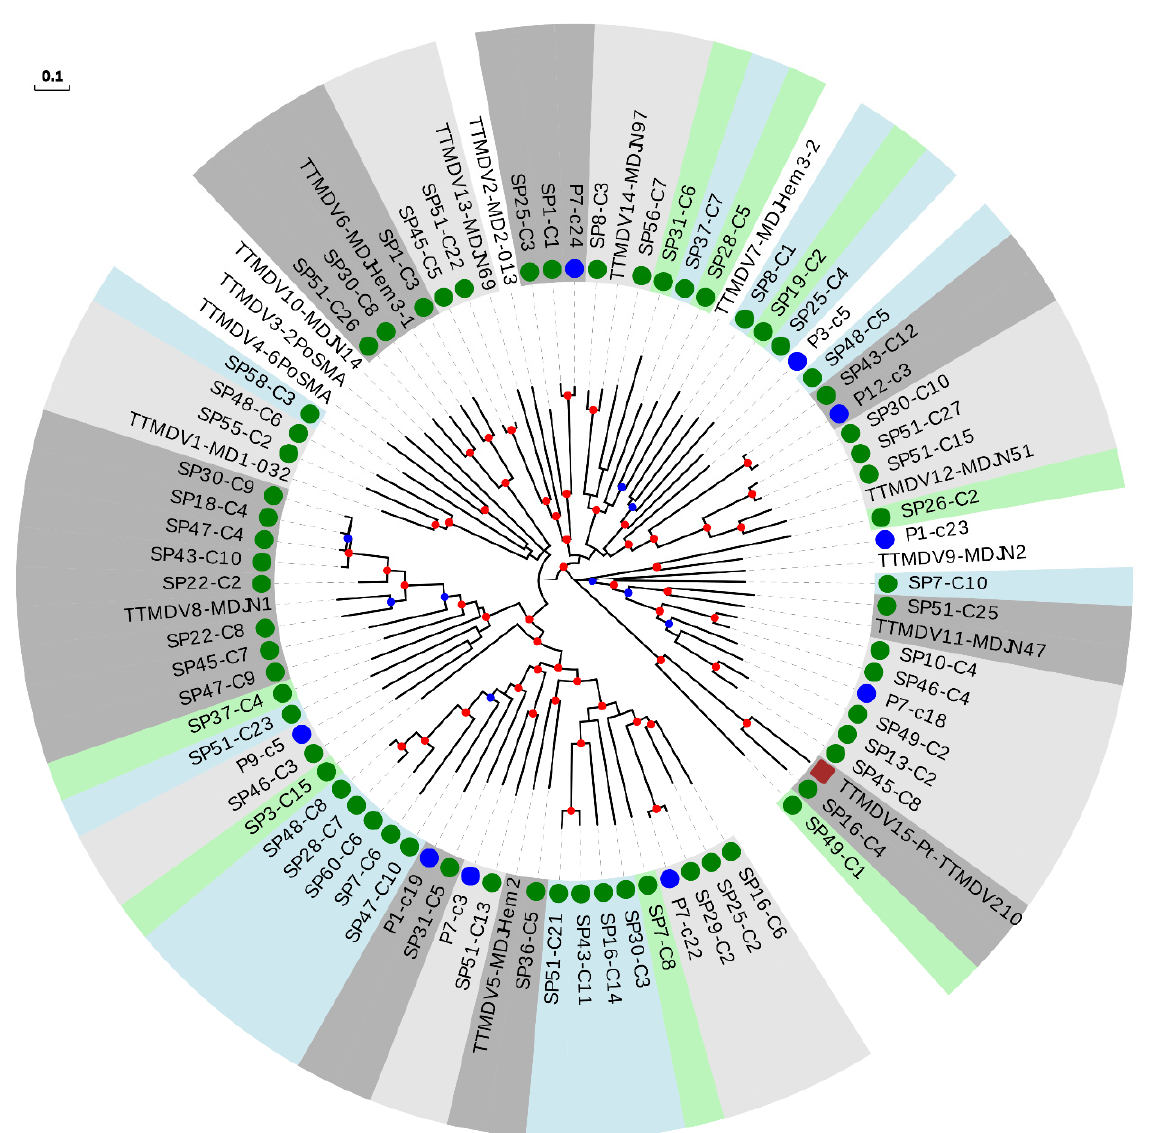
Figure 4. Phylogenetic tree of ORF1 sequences from the TTMDV genus. Sequences described in this study are marked with a green circle. Sequences identified as new species after reevaluating data from our previous study [18] are marked with a blue circle. New species (including one or more new sequences) are indicated with background green or blue color in order to distinguish contiguous clusters. Clusters of representative species including new sequences are indicated with background light or dark grey colors in order to distinguish contiguous clusters. The non-hominid primate isolate is marked with a brown square. Nodes supported by bootstrap values ranging 0.7–0.85 and 0.85–1.0 are indicated with blue and red circles, respectively. The scale bar indicates the evolutionary distance in nucleotide substitutions per site.